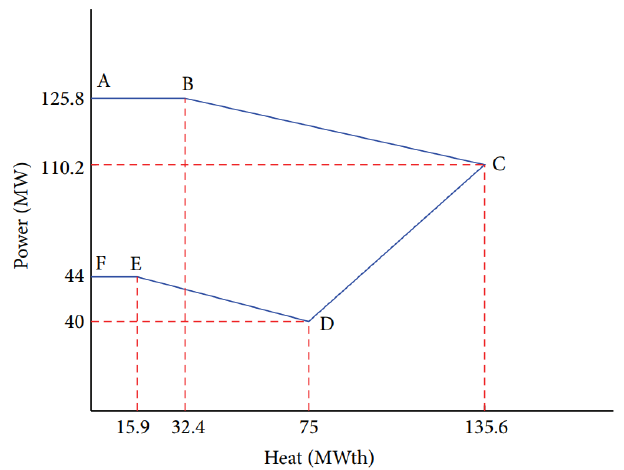
Figure 6. Power heat feasible operating region for CHP Unit